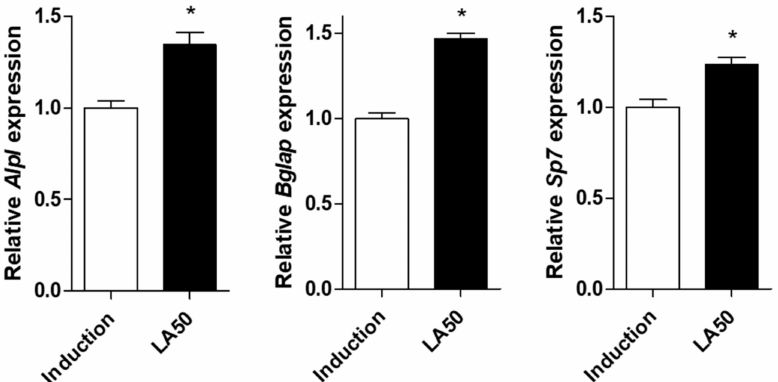
Figure 5. Effects of loganic acid on osteoblast differentiation-associated markers in MC3T3-E1 cells. After induction of osteoblast differentiation by co-treatment with 50 µ M loganic acid, the mRNA expression levels of Alpl , Bglap , and Sp7 were evaluated by qRT-PCR using targeted gene-specific primers, and the expressions were normalized using mouse Gapdh mRNA level. LA: loganic acid, Induction: osteoblast induction media-treated group. * p < 0.05 vs. Induction (Student’s t